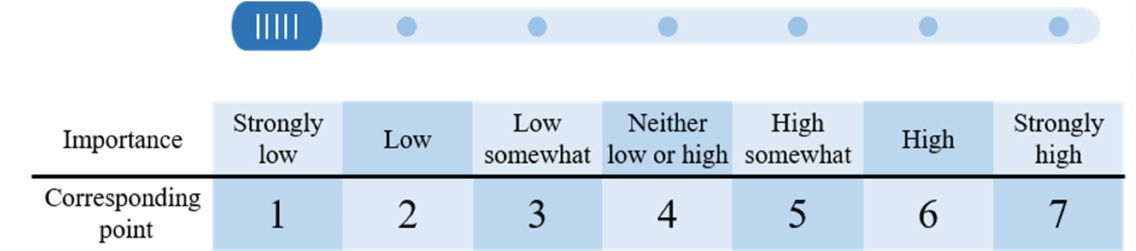
Figure 3. The seven-point Likert scale.